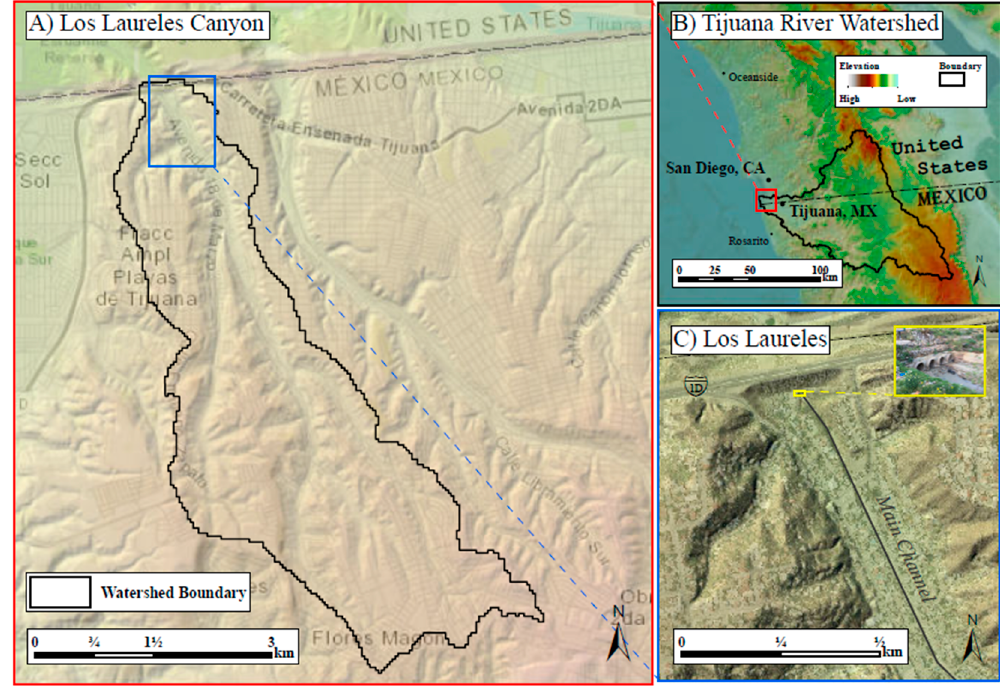
Figure 1. Los Laureles Canyon (LLC) in Tijuana, Mexico drains north across the U.S. border into the Tijuana River Valley ( A ), which terminates at the Pacific Ocean. The broader geographic context and the Tijuana River Watershed are shown in ( B ). A roadway embankment marks the northern border of LLC, and undersized culverts lead to the deep ponding of flood water during extreme events ( C ). The Los Laureles community is the neighborhood near the Northernmost point of Los Laureles Canyon at the U.S.–Mexico border, roughly represented by the blue box in ( A ).